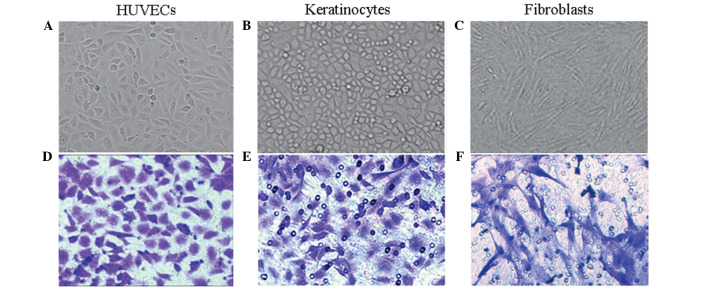
(A) Human umbilical vein endothelial cells (HUVECs), (B) keratinocytes and (C) fibroblasts from skin, ×100 magnification. Cells stained with crystal violet after migration, (D) HUVECs, (E) keratinocytes and (F) fibroblasts, ×200 magnification.